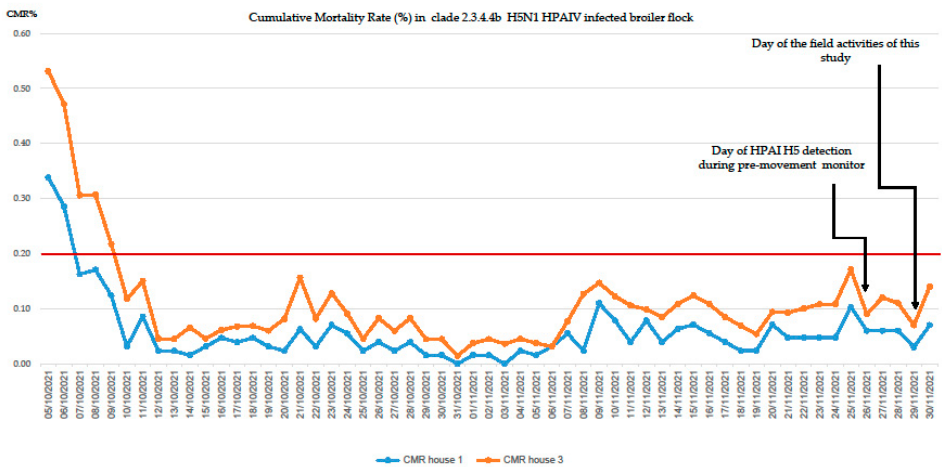
Figure 3. CMR, Cumulative Mortality Rate (%) of infected holding during the entire production cycle. House 1 CMR data (blue) and house 3 CMR (orange). The red bar indicates the value of 0.2% CMR-early warning of suspect AIV infection.